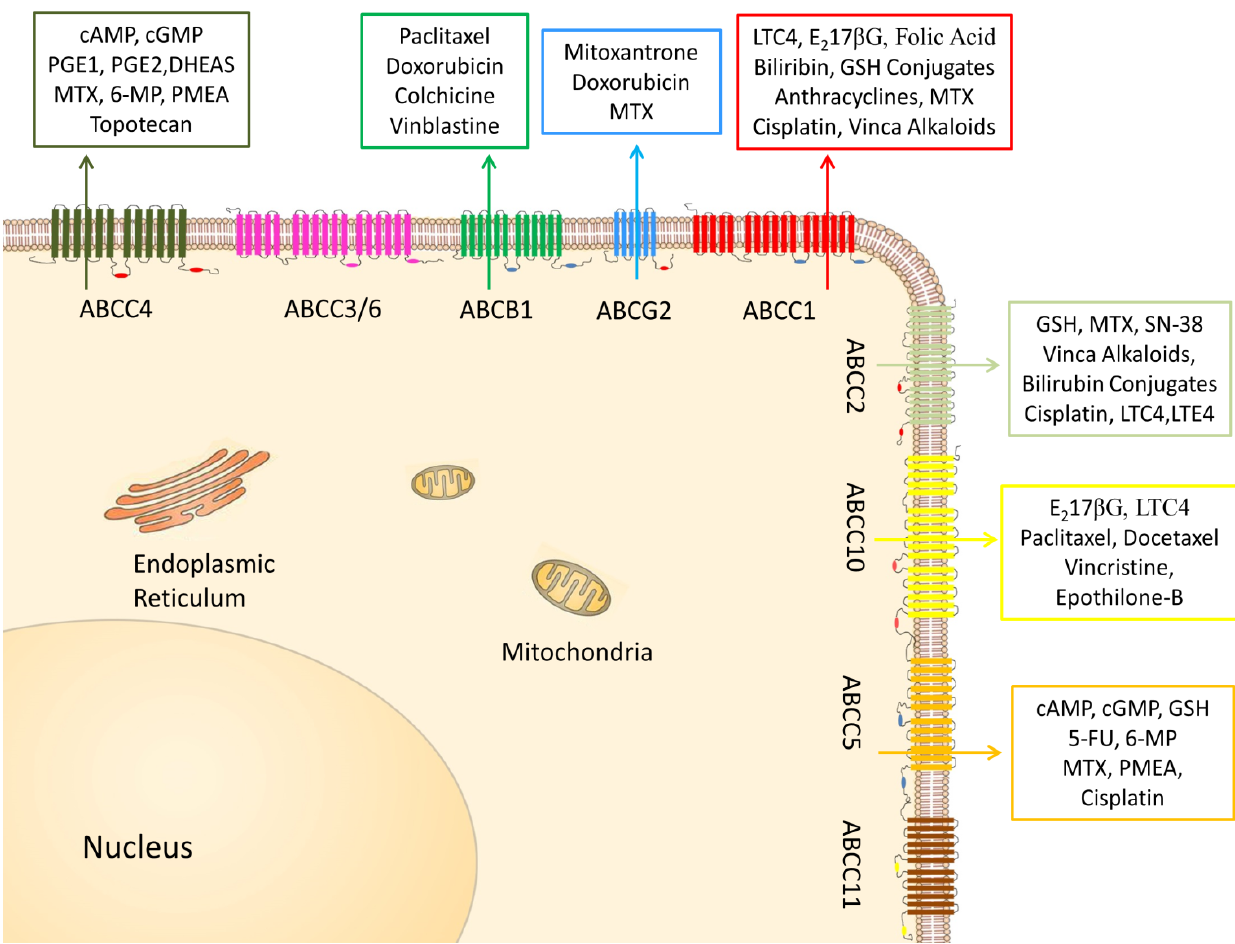
Figure 2. The topography and localization of ABCB1, ABCG2, short-(ABCC4, ABCC5, ABCC11) and long-(ABCC1, ABCC2, ABCC3, ABCC6, ABCC10) forms of ABCCs.